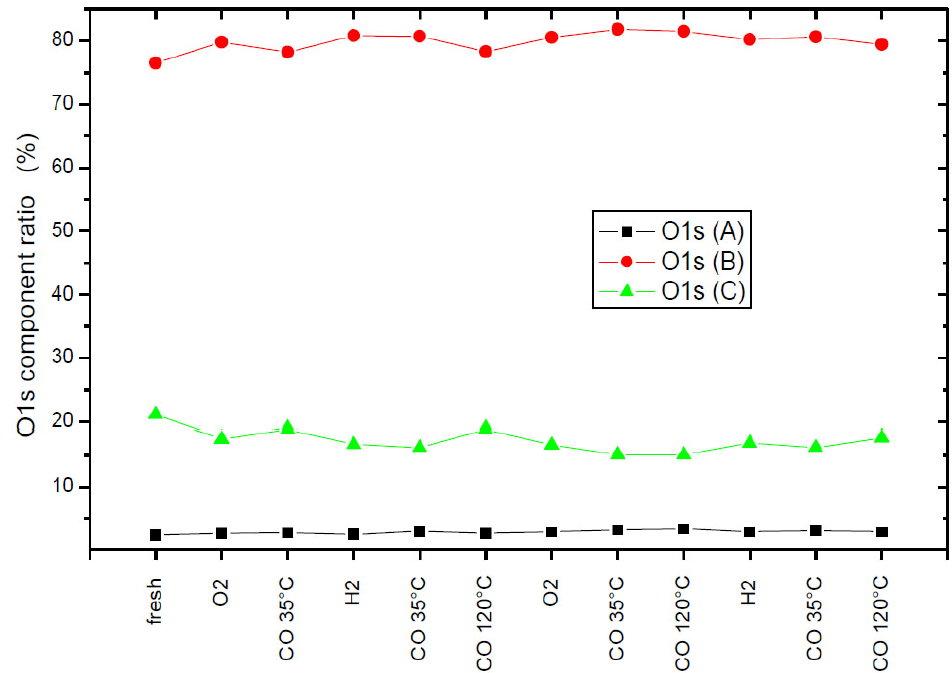
Figure 5. O 1s component line contents. ( A ) Oxygen bound to a metal of high electronegativity or in defected structures, BE ≈ 528.5; ( B ) Oxygen bound to metal (bulk oxygen), BE ≈ 530.2; ( C ) Oxygen in OH groups adsorbed on a metal or in CO, or in adsorbed organic compounds, BE ≈